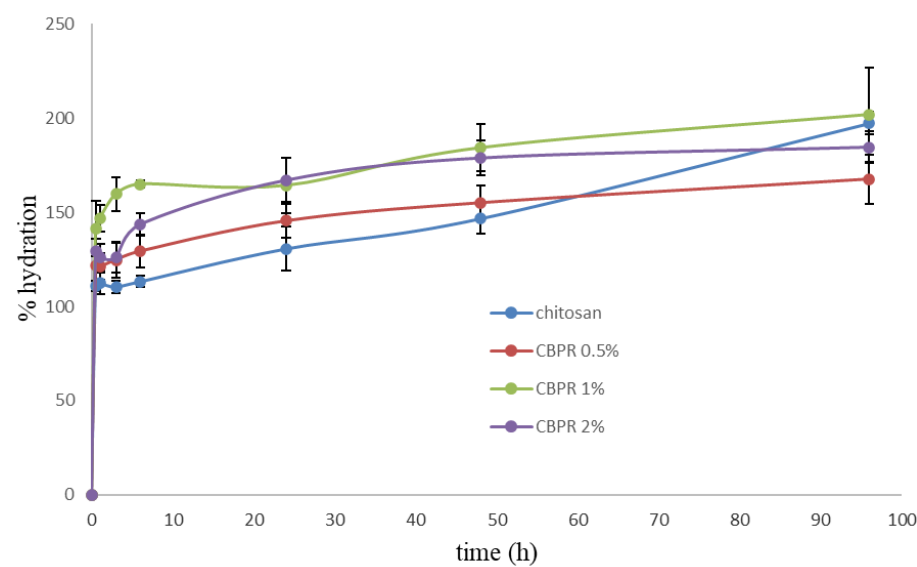
Figure 4. Percentage of hydration of the CBPR films as a function of time. Results are reported as an average ± SD.